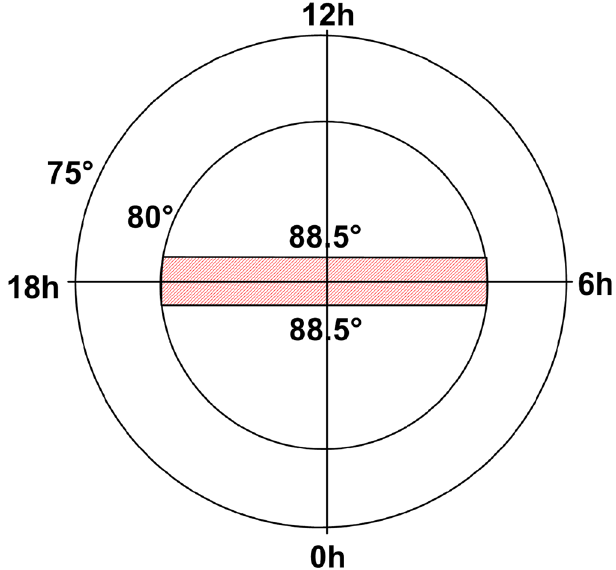
Fig. 9. Sector used for patch analysis.